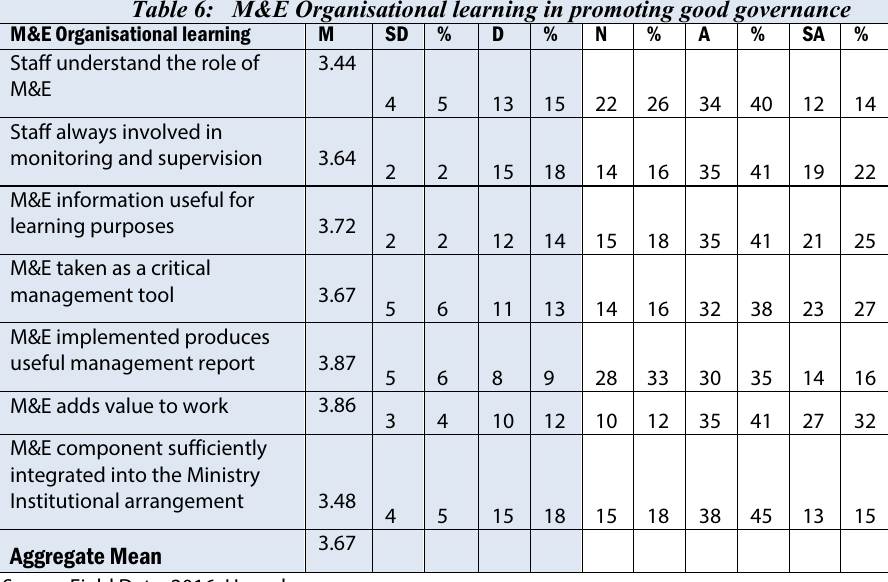
Table 6: M&E Organisational learning in promoting good